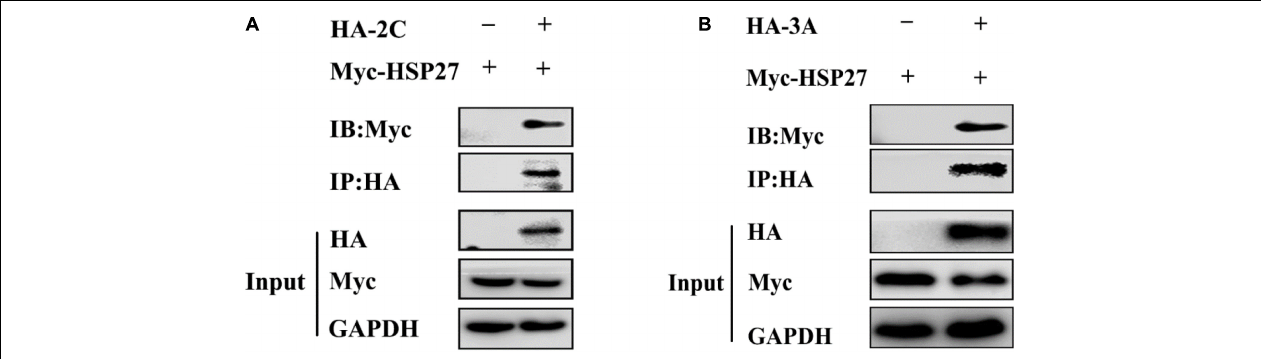
FIGURE 3 | 2C pro and 3A pro interact with HSP27. (A) A549 cells were co-transfected with Myc-HSP27 together with either pCMV-HA or HA-2C for 36 h before performing co-immunoprecipitation (Co-IP) and immunoblotting with anti-HA antibody. (B) A549 cells were co-transfected with Myc-HSP27 together with either pCMV-HA or HA-3A for 36 h before performing Co-IP and immunoblotting with anti-HA antibody.